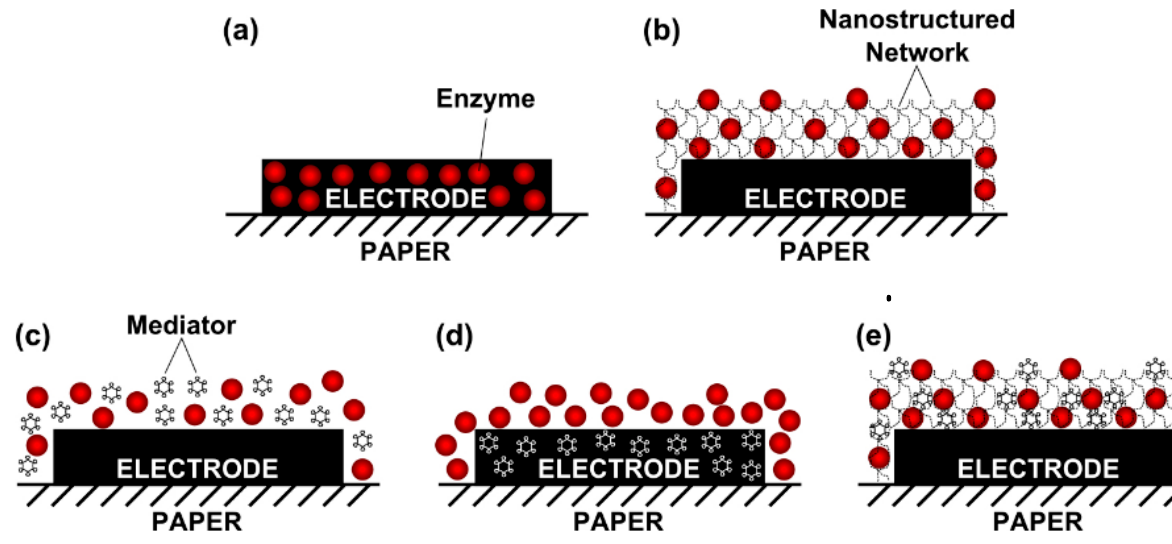
Figure 5. Electrode surface modification approaches of e-PAD biosensors: ( a ) enzyme-modified electrode; ( b ) nanostructured layer-modified electrode with biomolecule; ( c ) electrode modified with redox mediator and biomolecule; ( d ) electrode modified with redox mediator composite and bio- molecule; ( e ) electrode modified with biomolecule and redox mediator mixture over nanostructured layer, adopted from reference [25]. Open Access under CC BY-NC.